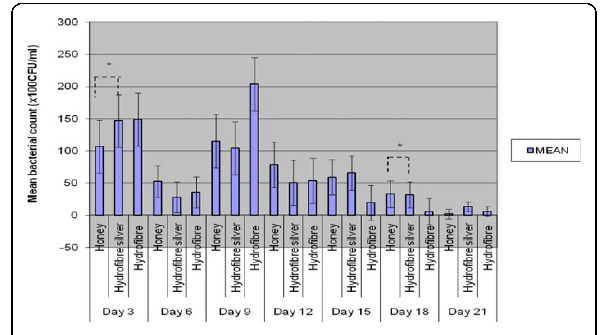
Figure 3 Comparison of colony count (CFU) among 3 wound dressings over time in Pseudomonas aeruginosa wounds . n = 36, * p <